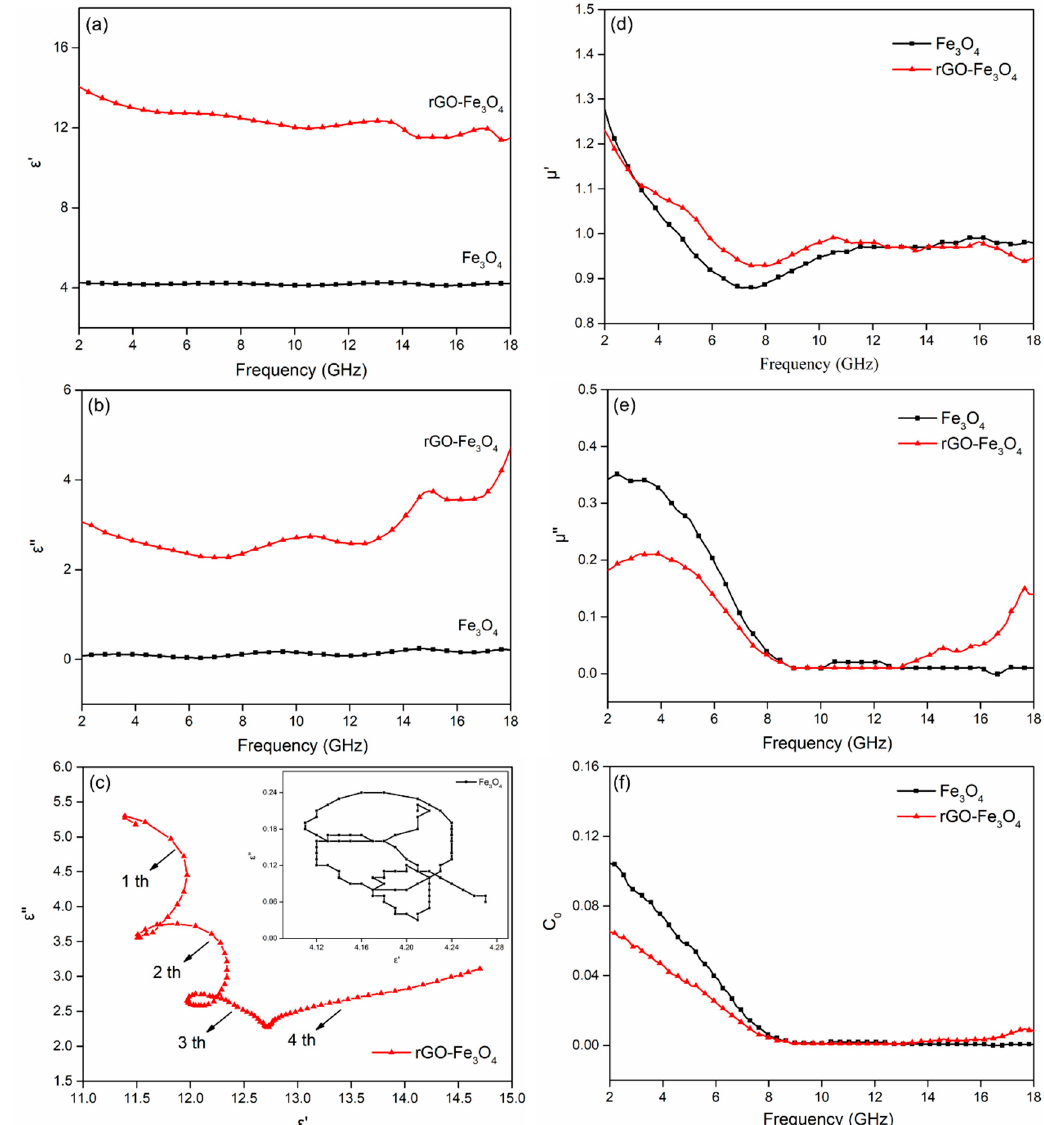
Figure 6. ( a ) Real and ( b ) imaginary parts of complex permittivity, ( c ) Cole–Cole semicircles ( ε ″ versus ε (cid:48) ), ( d ) real and ( e ) imaginary parts of complex permeability, and ( f ) C ε ′ ), ( d ) real and ( e ) imaginary parts of complex permeability, and ( f ) C 0 versus frequency for Fe 3 O 4 and rGO–Fe 3 O 4 rGO–Fe 3 O 4 .